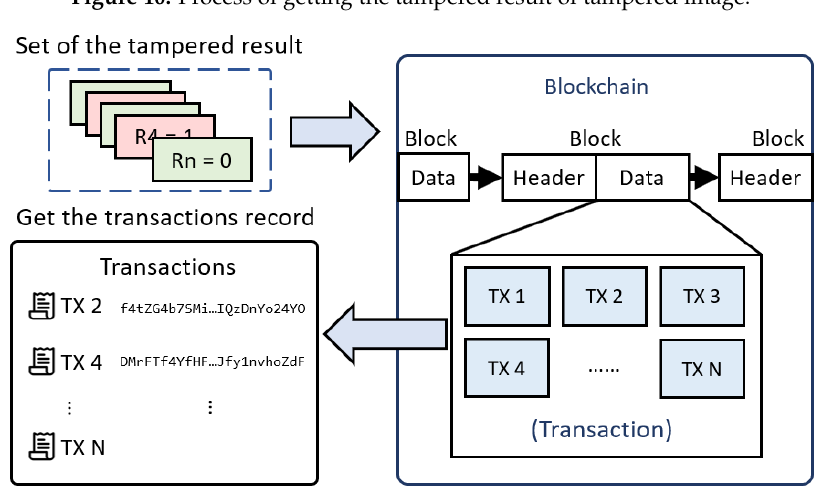
Figure 11. Process of getting the transactions